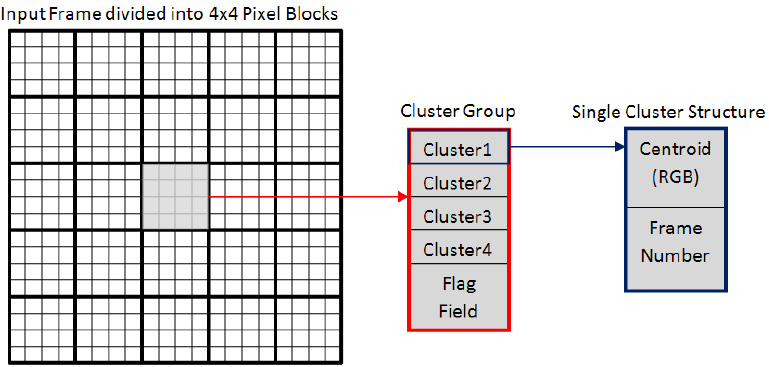
Figure 1. Clustering-Based Motion Detection Scheme.